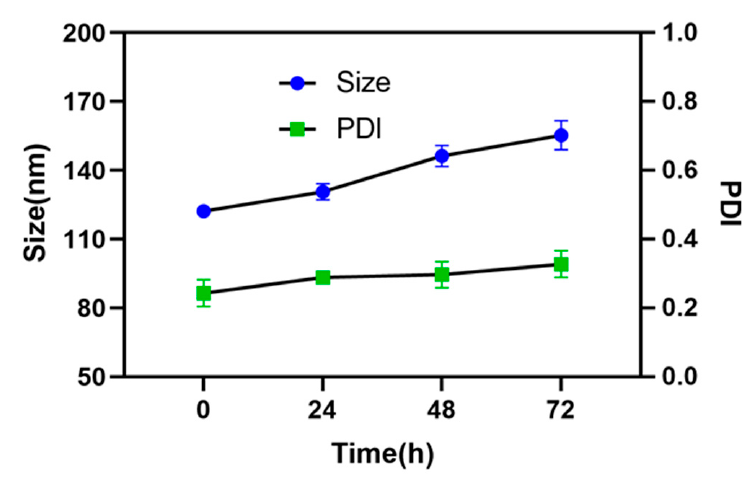
Figure 4. The result of stability of MMC NPs in 4 °C within 72 h.